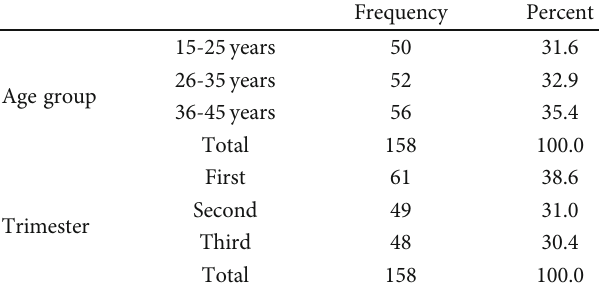
Table 1: Demographic characteristics of study